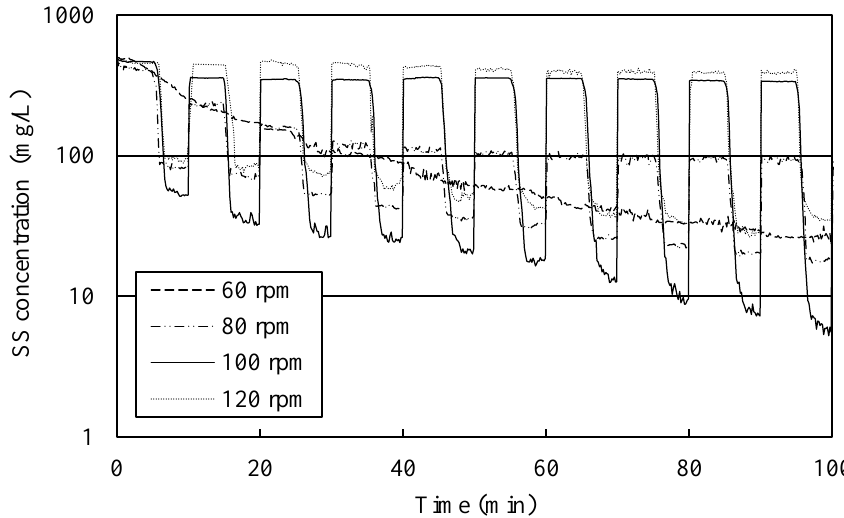
Figure 7. SS concentration variations with different paddle rotation speeds during intermittent agitation.